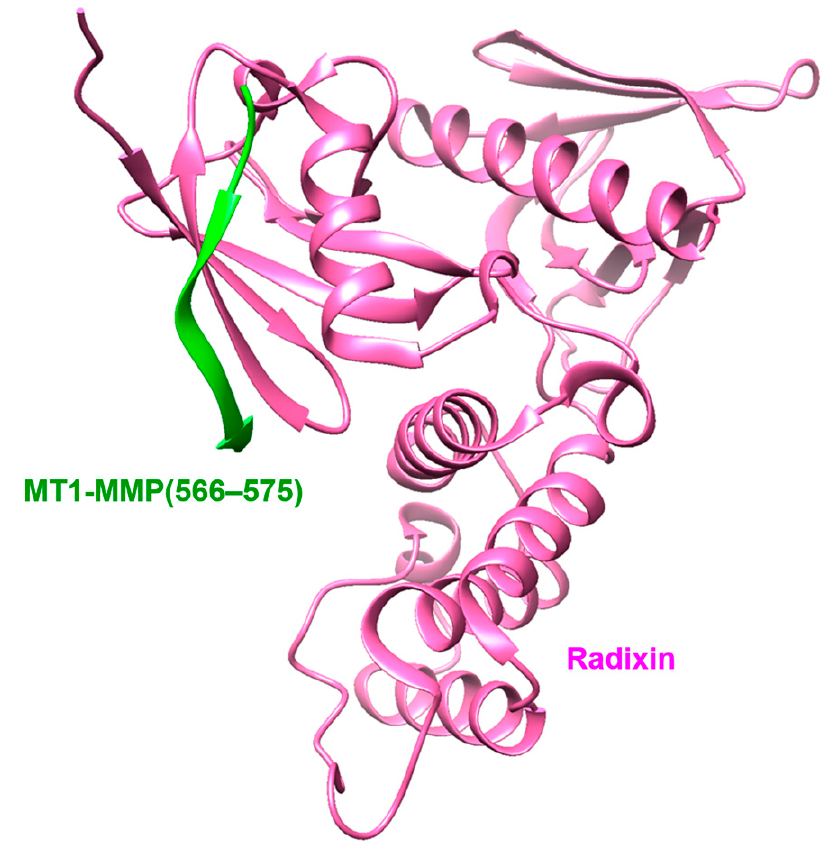
Figure 7. X-ray structure of the cytoplasmic domain of MT1-MMP (green) complexed with Radixin (pink): part of the ezrin/radixin/moesin (ERM) proteins. PDB code: 3 × 23.